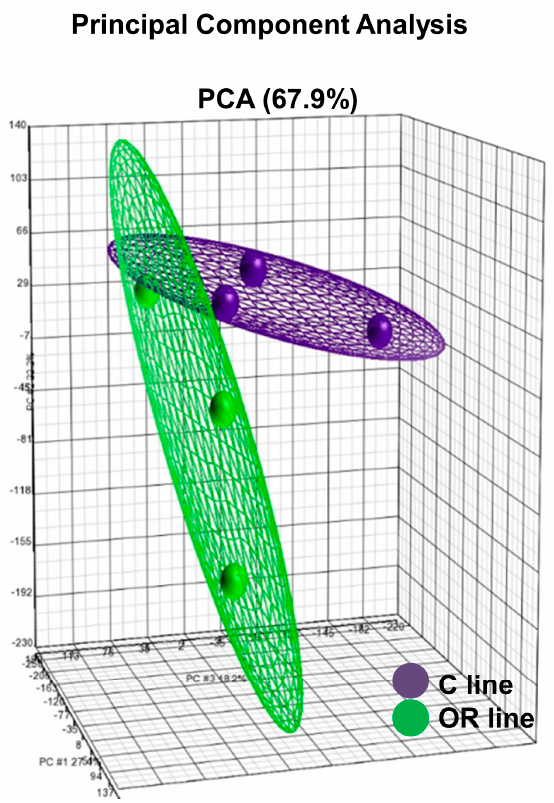
Figure 1. Principal component analysis (PCA) of the whole transcriptome of control line (C line, purple color) and line selected for ovulation rate during 10 generations (OR line, green color) in ovarian tissue. The total percentage of PCA mapping variability is 67.9%. Each data point represents one sample. The ellipsoids highlight the portioning of the di ff erent